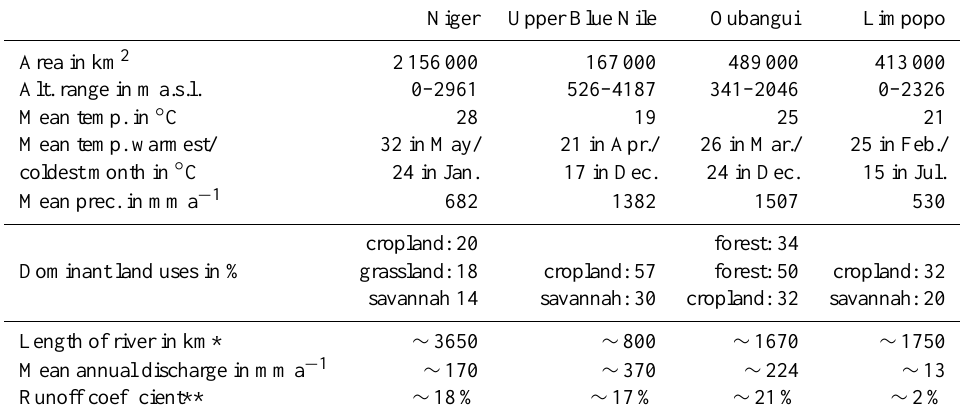
Table 1. Basin and river